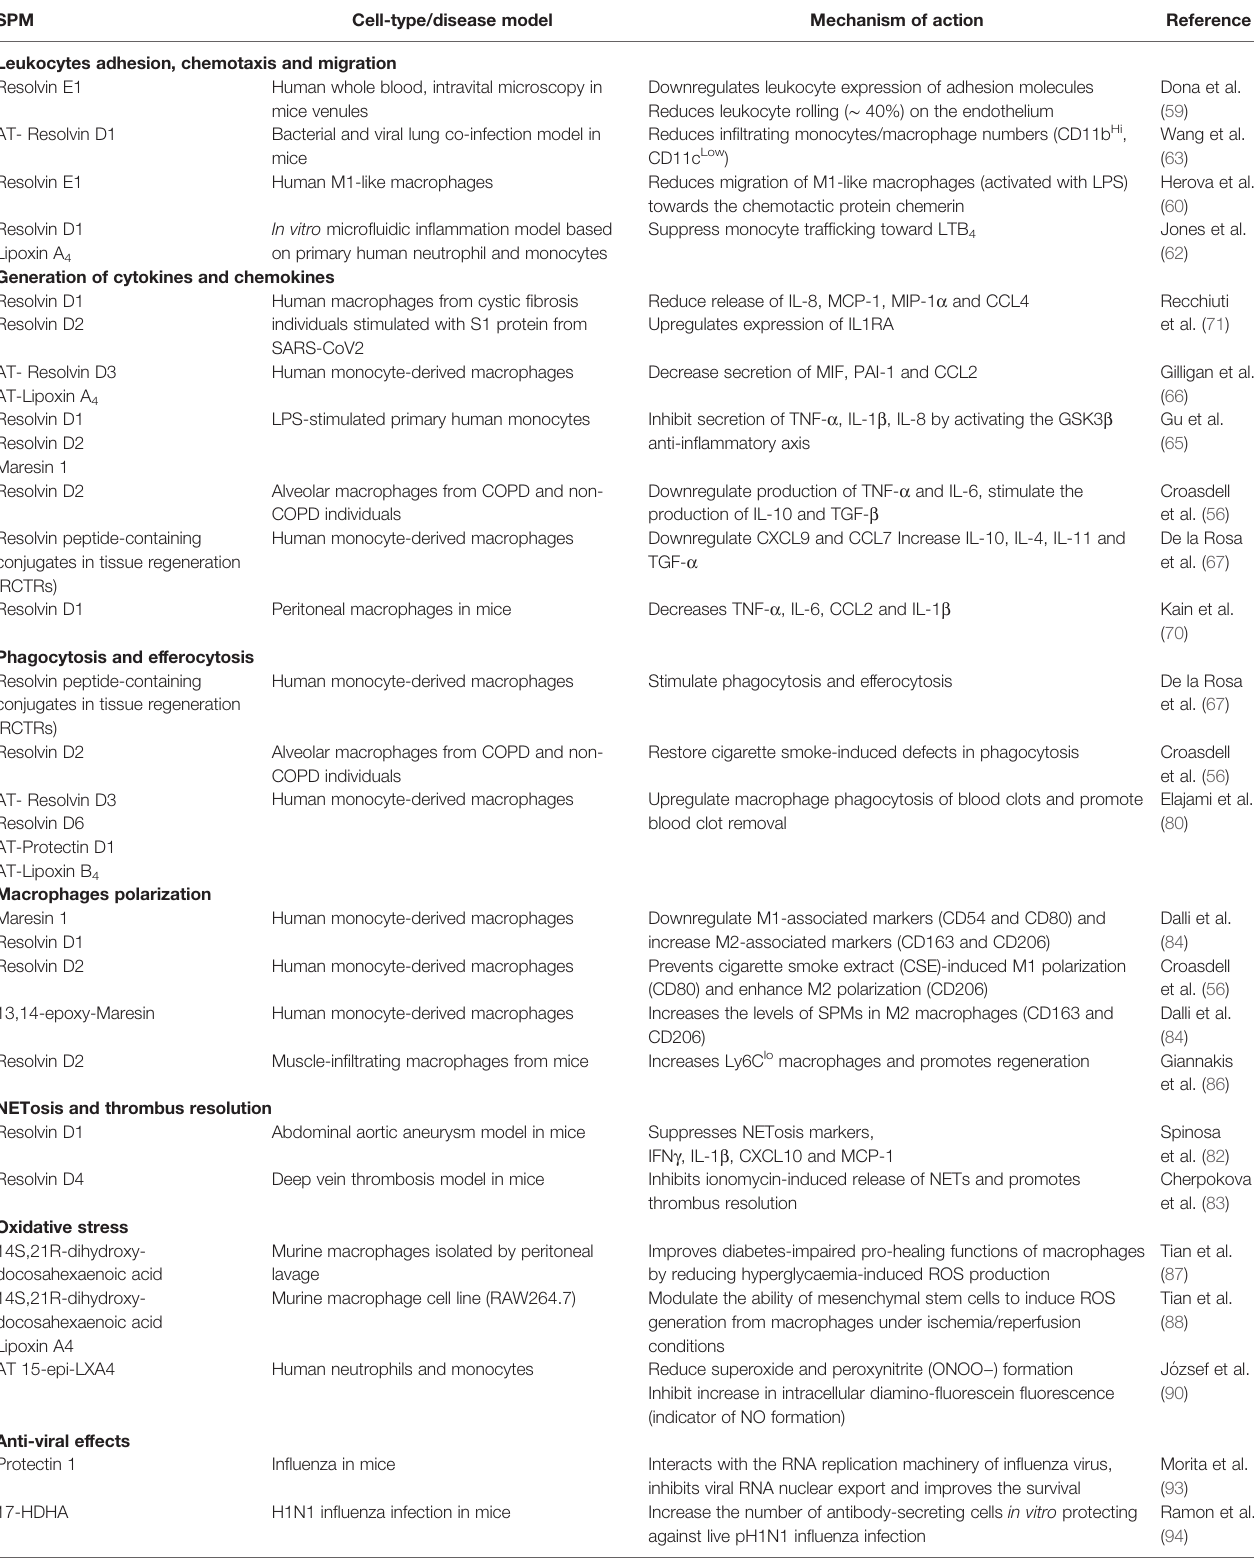
TABLE 1 | Immunoprotective actions of SPMs in relation to COVID-19